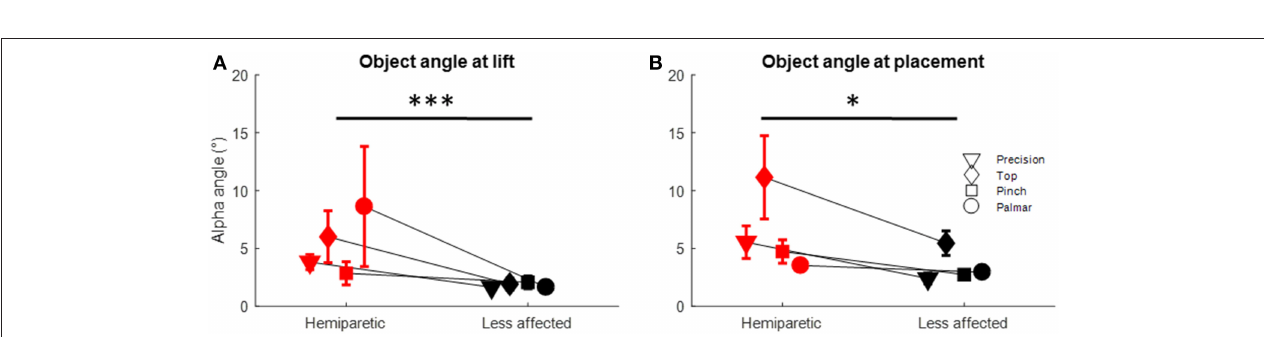
FIGURE 6 | Object orientation for the hemiparetic (red symbols) and less affected arms (black symbols) at: (A) Time of lift and, (B) Time of placement. *Dunn’s post-hoc p < 0.05; ***Dunn’s post-hoc p < 0.001.